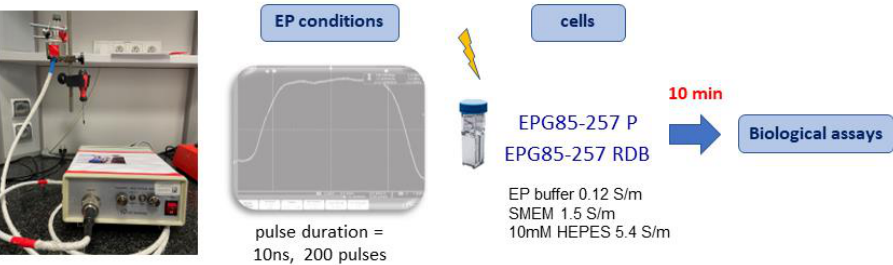
Scheme 1. Schematic representation of the experimental setup including the pulse-generation system and the signal shape from the oscilloscope.